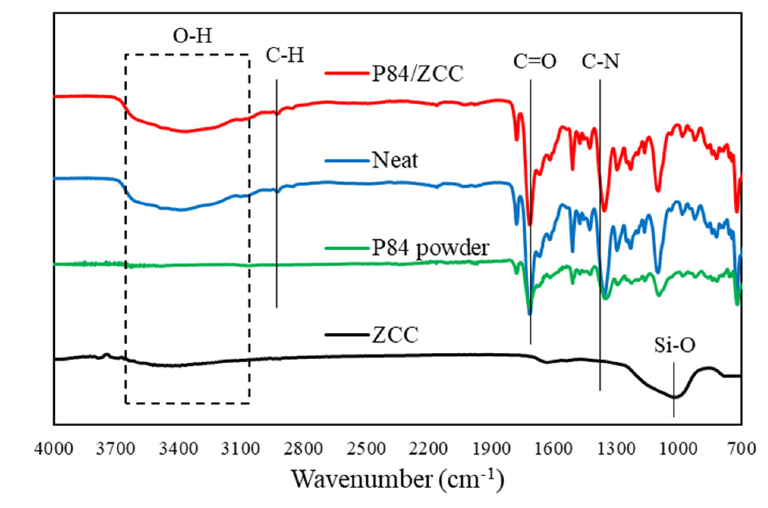
Figure 2. The FTIR spectra of all prepared samples.